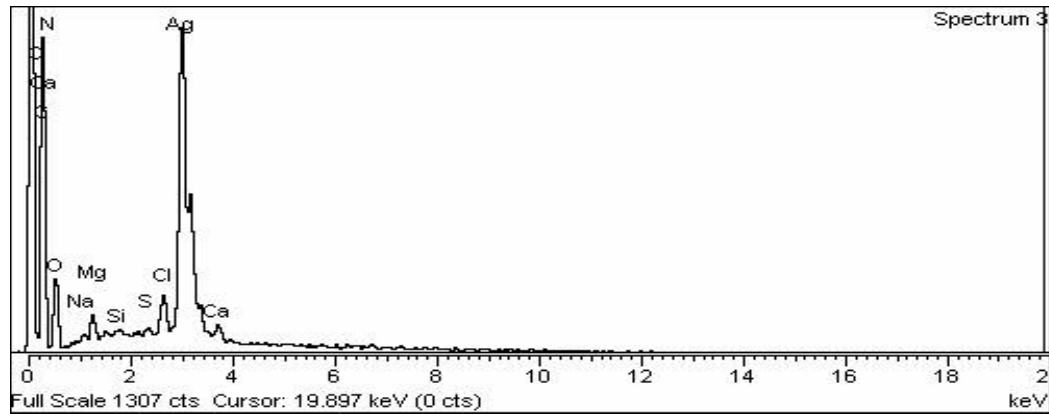
Figure 5. EDX spectrum representing elemental analysis of the greenly synthesized AgNPs.